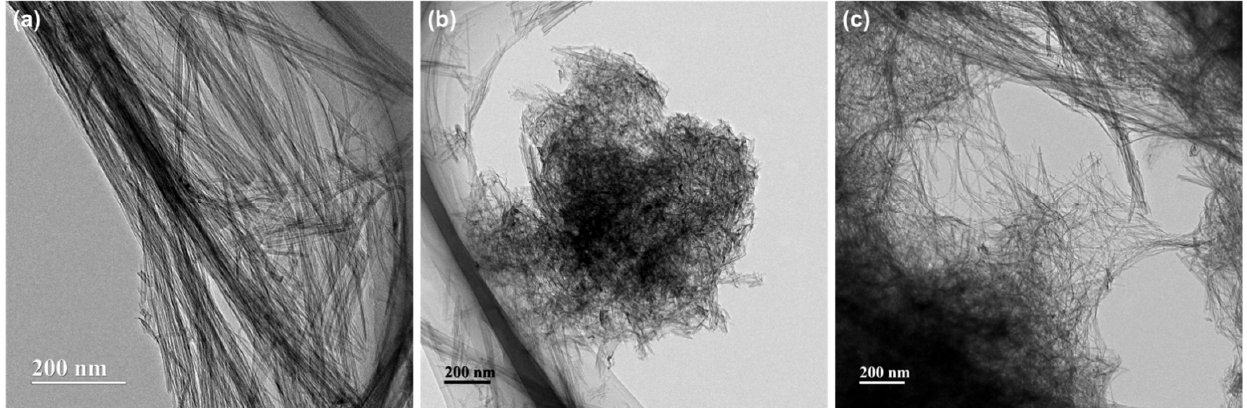
Figure 4. TEM images of synthesized ( a ) Pure TNT, ( b ) Mo-TNT, and ( c ) W-TNT